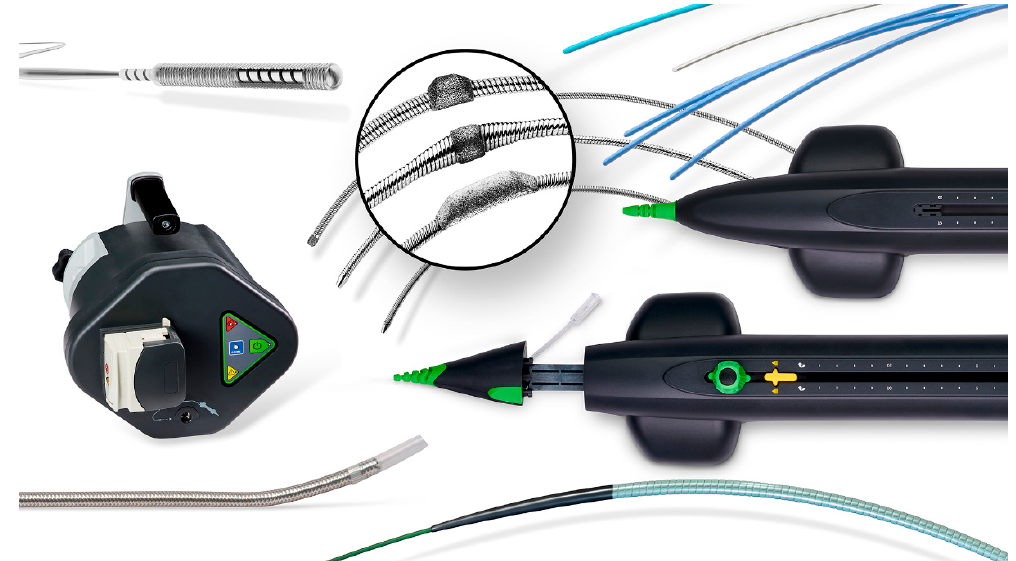
Figure 3. CSI Diamondback 360 Peripheral Orbital Atherectomy System. Courtesy of Cardiovascular Systems, Inc.